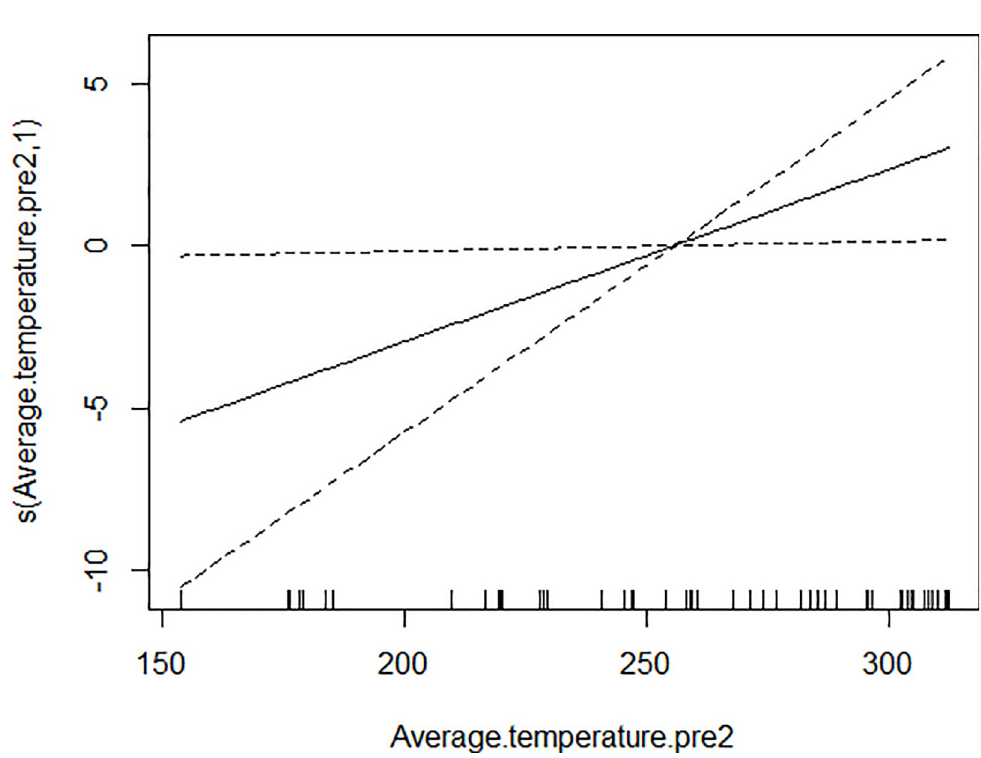
Fig 9. The relationship between female Ae . albopictus density and average temperature pre 2 weeks. https://doi.org/10.1371/journal.pone.0234555.g009 PLOS ONE | https://doi.org/10.1371/journal.pone.0234555 June 11,